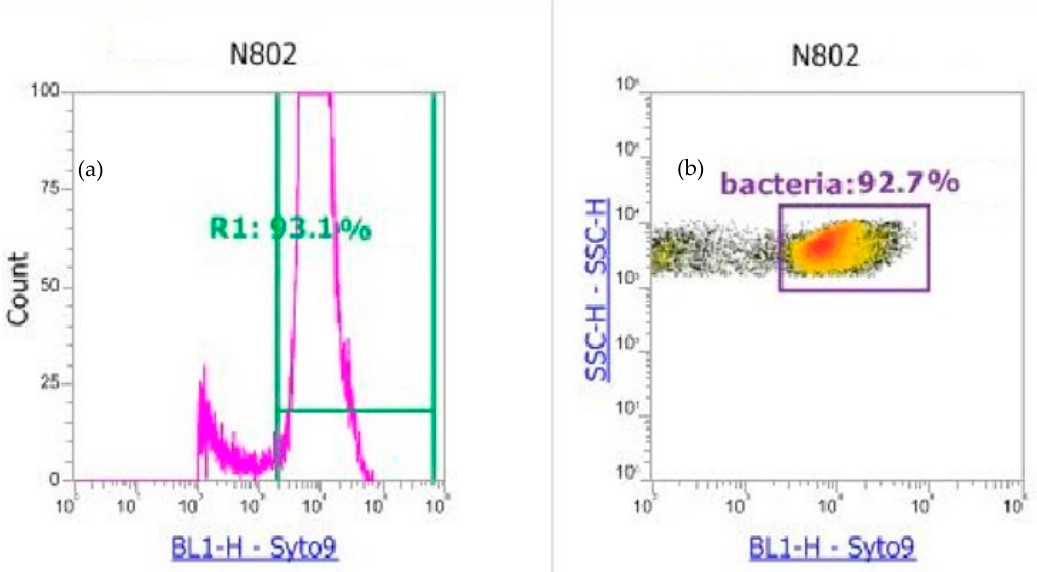
Figure 4. Determination of the bacteria detection zone R1 ( a ) and ( b ) the associated population counting isolated by the R1 gate, were SSC-H—SSC-H is the size scatter and BL1-H the fluorescence induced by the blue laser.